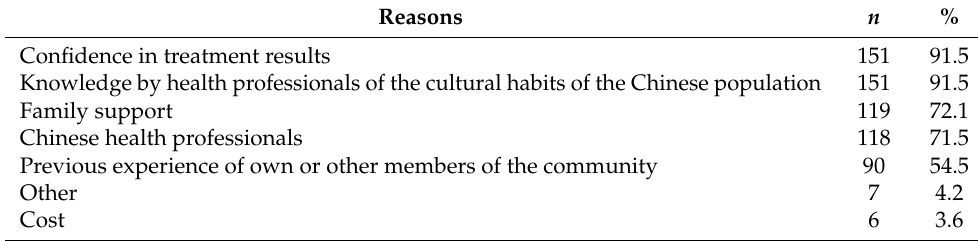
Table 5. Reasons for seeking healthcare in China ( n = 165).